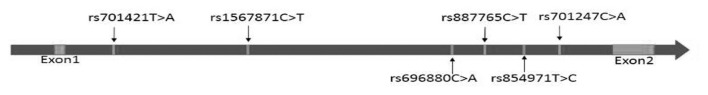
Genomic structure and localization of polymorphisms in the RTN4R gene.